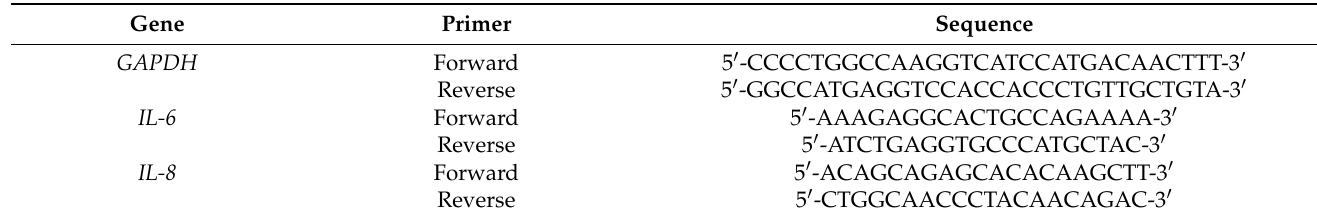
Table 1. Primer sequences of the genes used in the